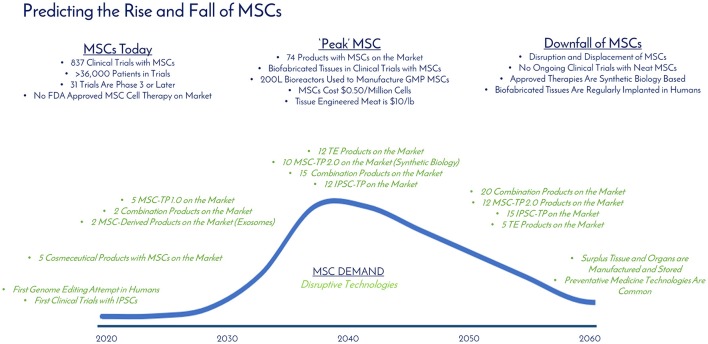
Predicting the rise and fall of MSCs. The current, “peak,” and downfall stages of MSC demand are detailed with milestones over time (blue). Disruptive technologies (green) that are developing in parallel that have the potential to displace MSC demand are detailed over time. “Peak” MSC is predicted to occur in 2040.